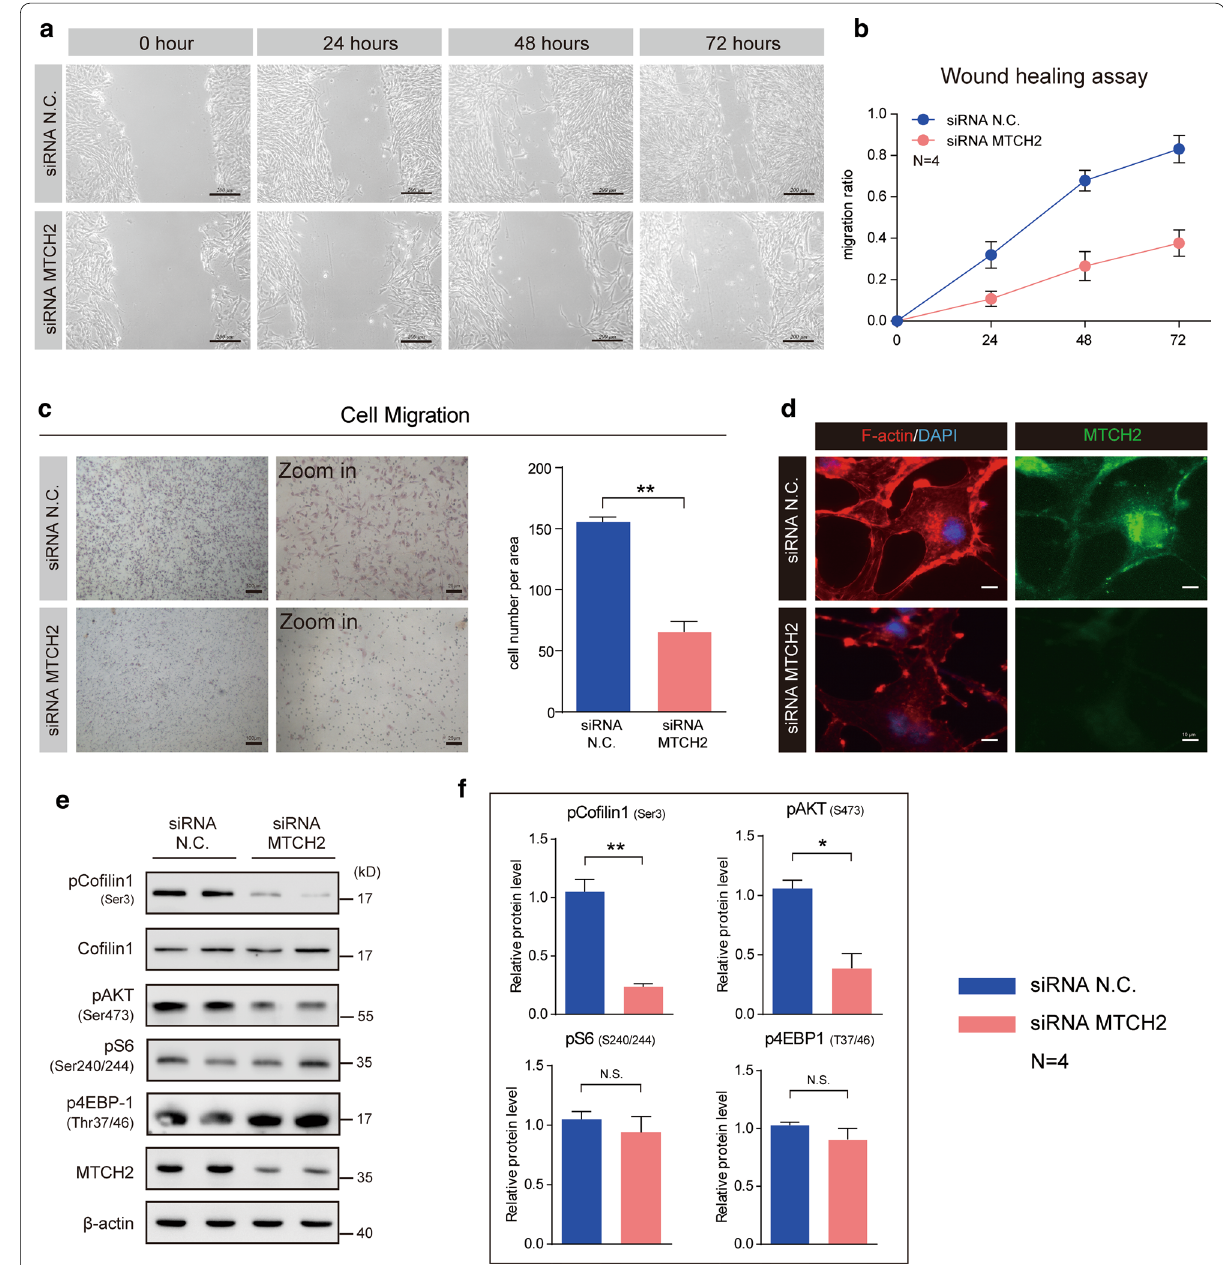
Fig. 4 MTCH2 knockdown impairs the migration of glioma cells in vitro. a , b Representative images of wound healing assays showing that MTCH2 knockdown inhibits the migration of A172 cells (N 4). The migration of cells into the wound was assessed at 0, 24, 48 and 72 h. Scale = bar, 200 μm. c Images and quantifications showing that MTCH2 knockdown reduces the rate of migration of U87 MG cells by Transwell migration assays. d Immunostaining images showing the reduced F-actin fibers by MTCH2 knockdown in A172 cells. Scale bar, 10 μm. e , f Western blots and quantifications showing that MTCH2 knockdown alters cellular signalings relative to cytoskeleton